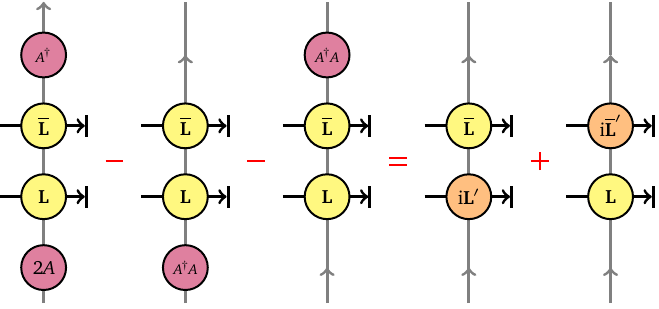
Figure 5: Graphical interpretation of the boundary compatibility condition as given by equa- tion (23) displayed for the right boundary at lattice site N . The left-hand side shows schemat- ically the action of the dissipator (cid:68) on the (cid:76) -operator decomposed into three terms which the define the action of the jump operator A . The termination point of the horizontal arrow sig- N nifies the contraction with the right auxiliary vacuum state. Note that the boundary condition has to be satisfied for all values of physical